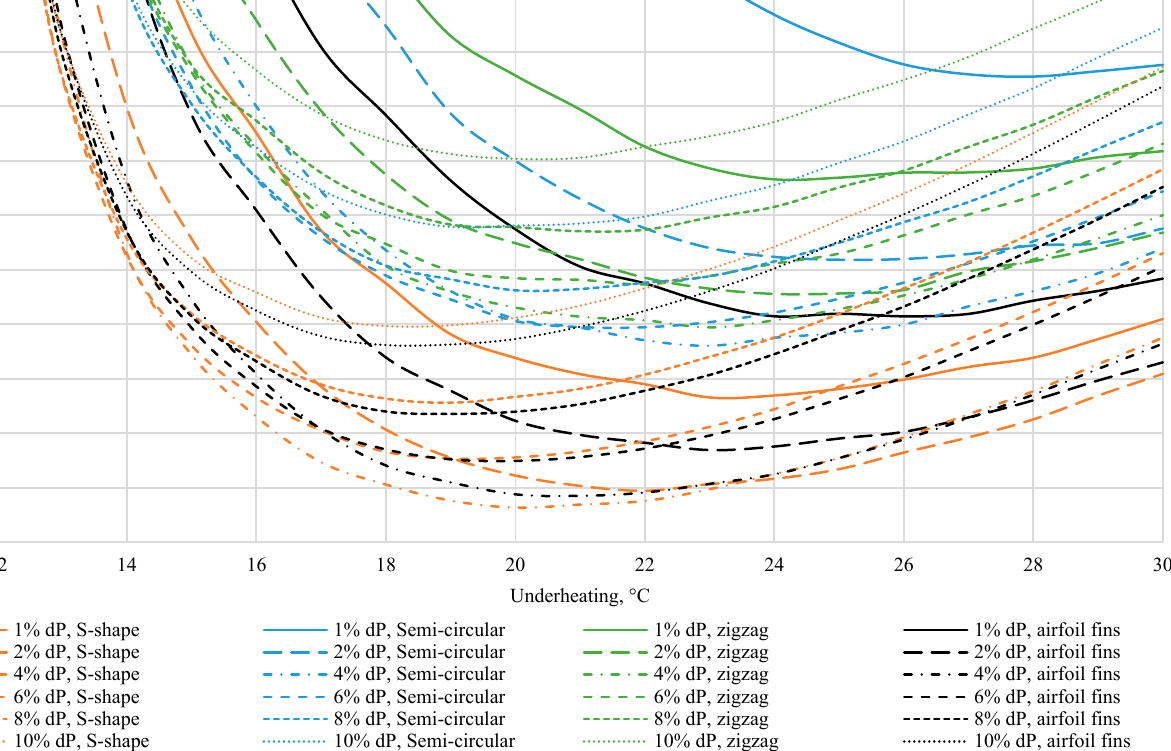
Figure 13. Total expenses on the regeneration system vs. underheating and pressure losses.